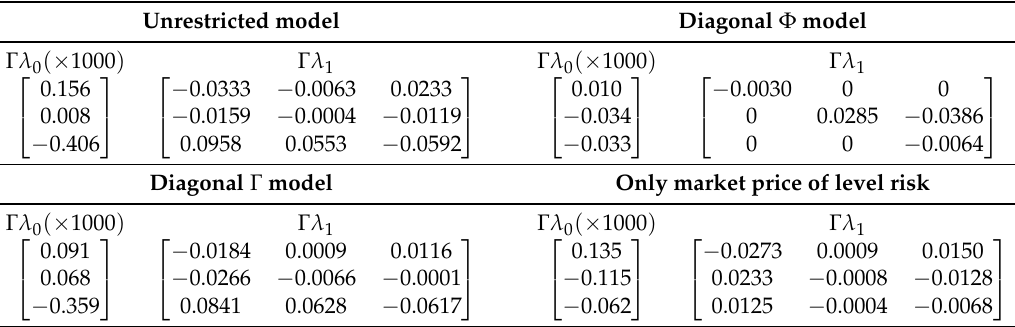
Table 2. Estimated market prices of risk